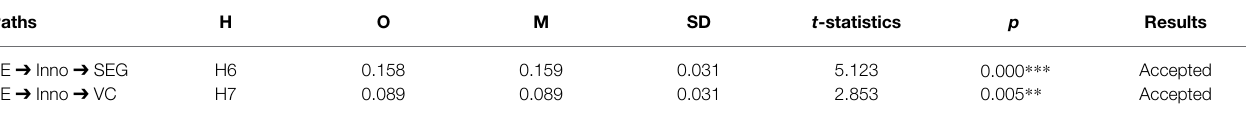
TABLE 7 | Indirect effects of the variable. Paths H O M